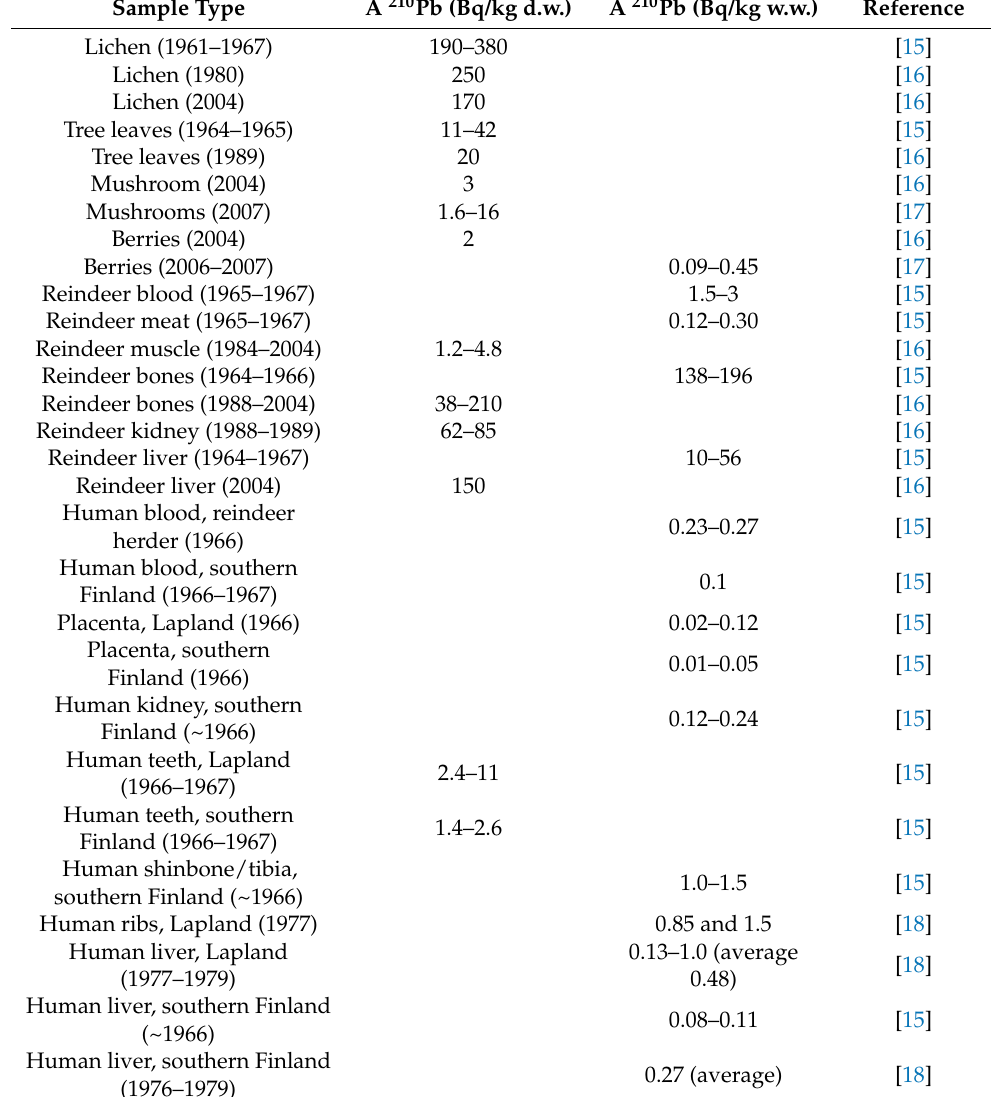
Table 1. Concentrations of 210 Pb in Finnish environmental and biological samples. d.w. = dry weight, w.w. = wet weight. Sampling year is in